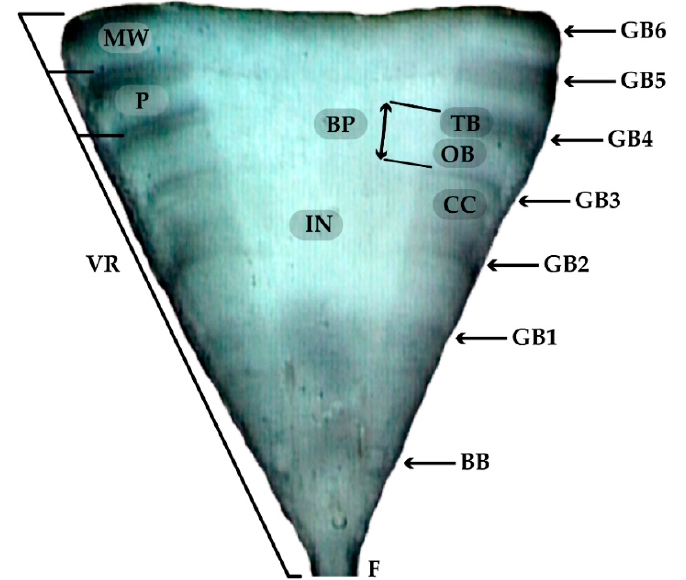
Figure 1. Sagittal section of a centrum of a six-year-old Narcine entemedor specimen, showing MW, marginal width; P, previous band pair width; VR, the vertebral radius; F, focus; CC, corpus calcareum; IN, intermedialia zone; BP, band pair; OB, opaque band; TB, translucent band; BB, birth band; GB, growth bands.